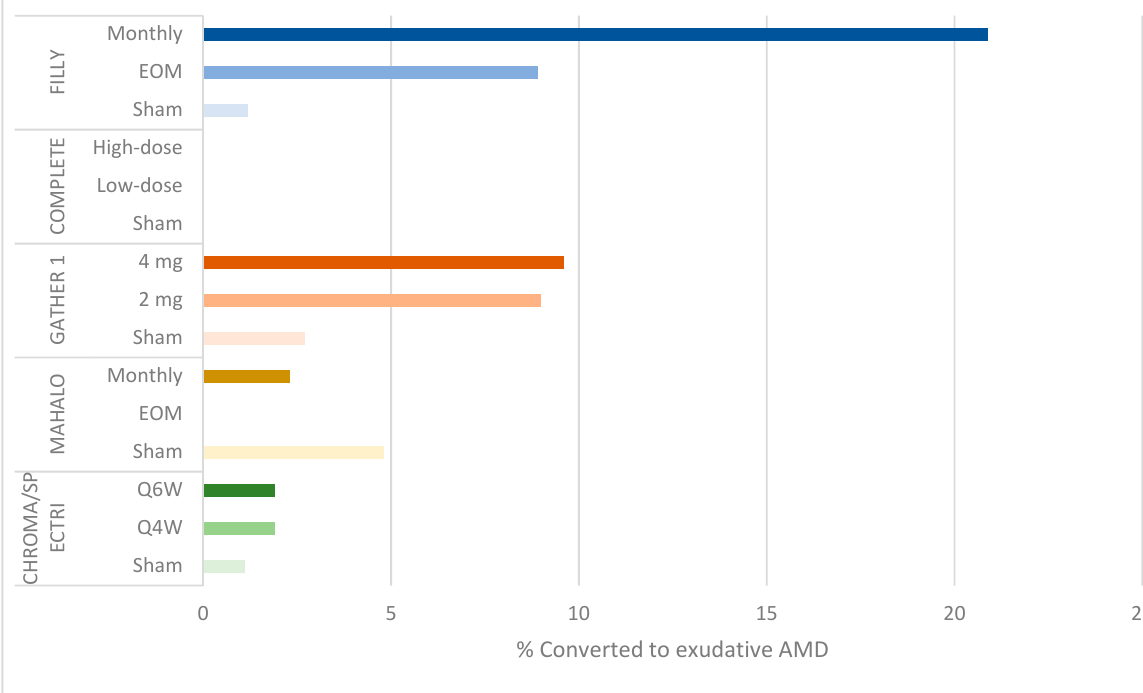
Figure 3. Bar graph showing percentage of conversion to exudative AMD by study group. Despite the limitations of the FILLY study, two phase 3 trials have been approved and are currently under way to evaluate the efficacy of pegcetacoplan in patients with GA (NCT03525613 and NCT03525600). 3.2. C5 Inhibition In the terminal steps of the common final pathway of the complement cascade, com- plement component 5 (C5) is cleaved into C5a and C5b by C5 convertase (C4bC2bC3b or C3bBbC3b). C5a is an anaphylatoxin with a function similar to C3a, while C5b recruits other complement proteins (C6, C7, C8 and C9) to assemble the pathogen-killing MAC (C5b–C9). Antibodies and aptamers targeting C5 prevent its cleavage, and thus, prevent both recruitment of inflammatory cells and MAC formation. Given that C5 inhibition al- lows for residual upstream complement pathway activity, this strategy theoretically pro- vides some benefits of complement inhibition while minimizing potential adverse effects. Anti-C5 therapies being studied for treating GA include the antibodies eculizumab (Soliris ® ; Alexion Pharmaceuticals, Boston, MA, USA) and LFG316 (Novartis, Basel, Swit- zerland), as well as the aptamer avacincaptad pegol/ARC1905 (Zimura ® ; IVERIC Bio (for- merly, Ophthotech), Cranbury, NJ, USA). Eculizumab, which is a FDA-approved therapy for the treatment of paroxysmal noc- turnal hemoglobinuria, underwent a randomized phase 2 trial for the treatment of GA sec- ondary to non-exudative AMD between 2009 and 2013 (COMPLETE, NCT00935883). IV